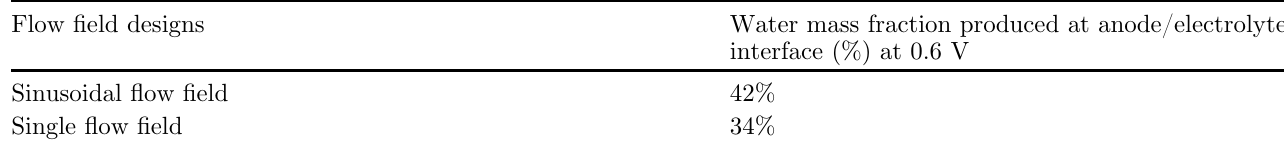
Table 6. Maximum value produced of Water mass fraction at the anode/ electrolyte interface. Flow fi eld